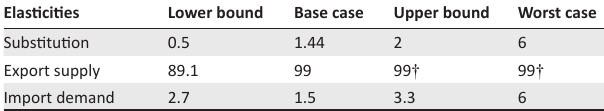
TABLE 1: Elasticities used in sensitivity